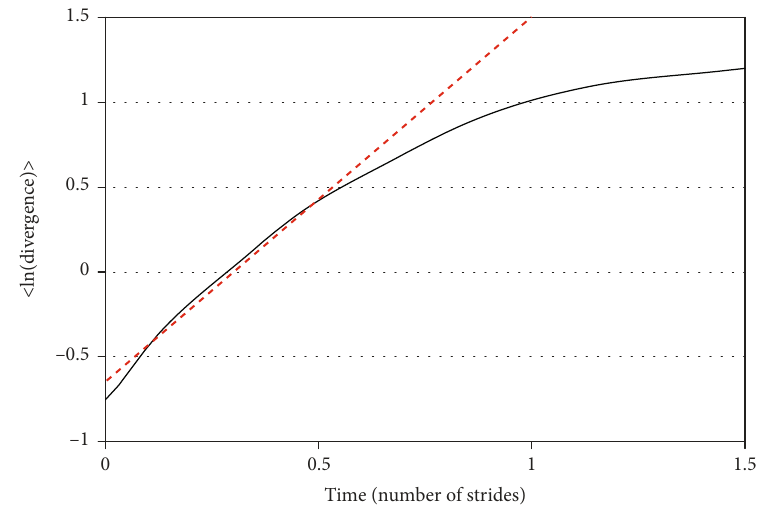
Figure 2: Average logarithmic divergence over